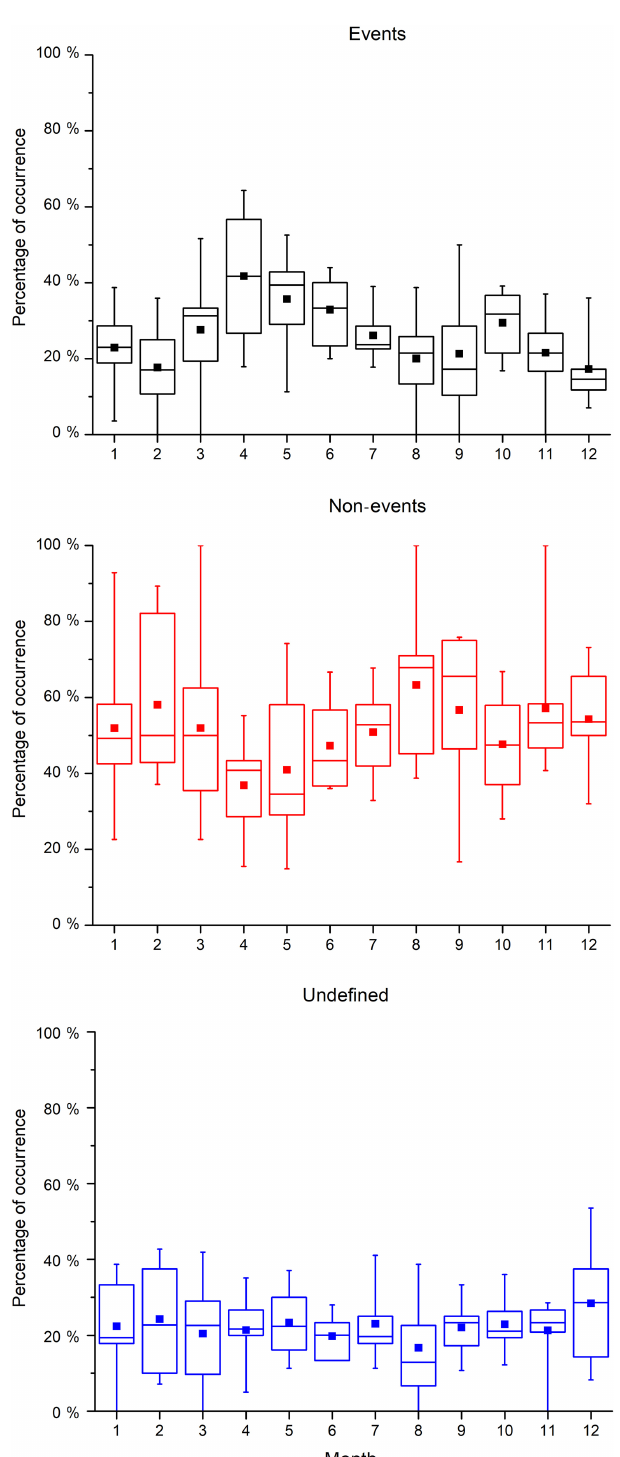
Figure 4. Seasonal variation in NPF percentage of occurrence of event, non-event and undefined days relatively to available mea- surement days at Finokalia for the period June 2008–June 2018. Whiskers represent 10th and 90th percentiles, box edges are 75th and 25th percentiles, the horizontal line in the box is the median, and the square is the mean.